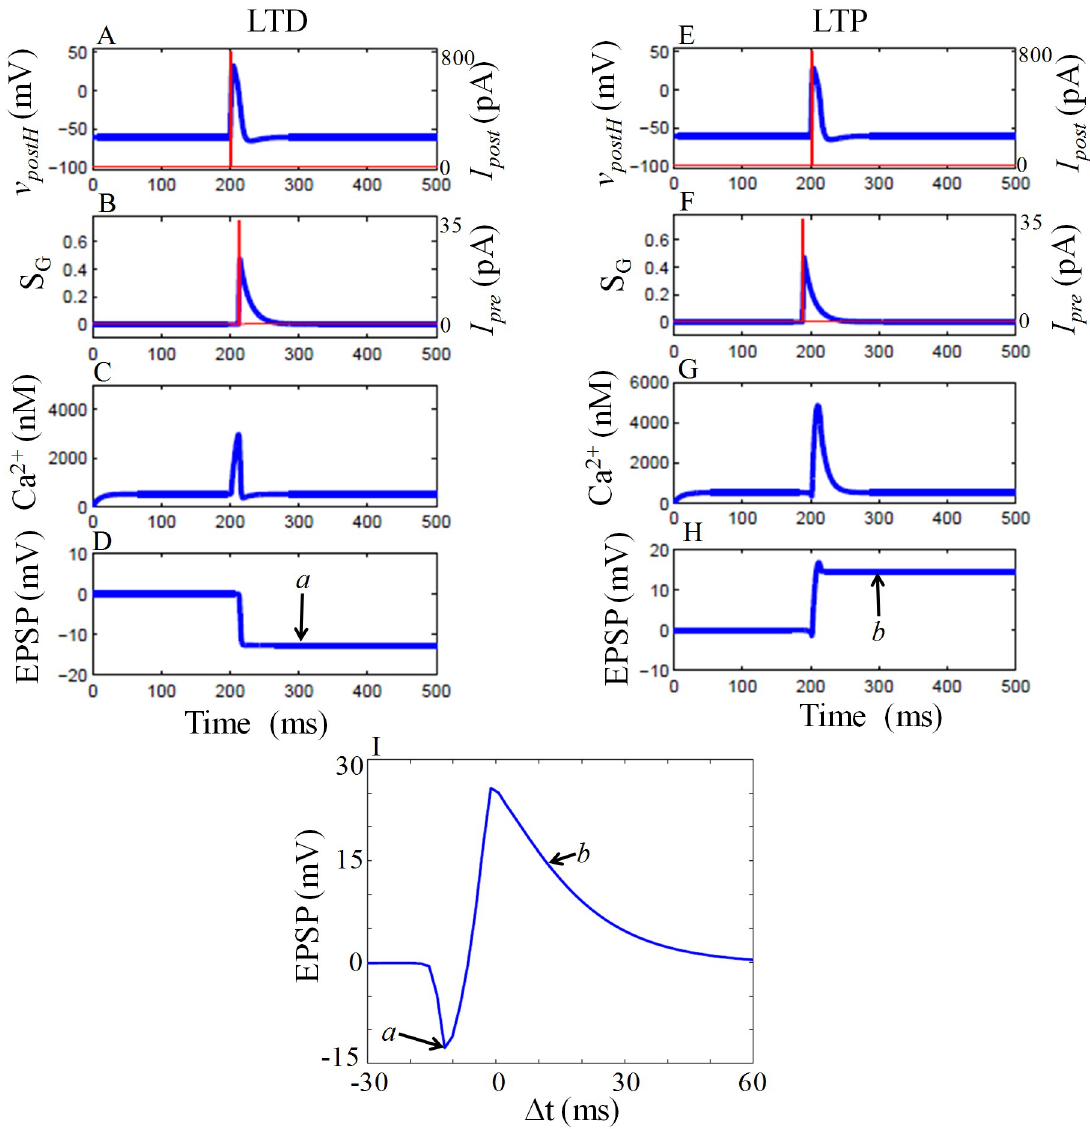
Fig 4. Time series of variables for STDP without GRN. In simulation, we apply I post at t = 200 ms (A, E, red line), which induce a spike at post-synaptic neuron (A, E, blue line). (B) When Δ t = − 12 ms , I fraction of glutamate binds to NMDAR (blue line). (C) Dynamics of the Ca 2+ . (D) Moderate increase of Ca 2+ level induce a negative change in the EPSP, which is the measure of LTD. (F) When Δ t = + 12 ms , I release and fraction of glutamate that binds on NMDAR (blue line). (G) Dynamics of Ca 2+ . In comparison to previous case in (C), increment of Ca 2+ level is higher that results in a positive change in the EPSP (H), a measure of LTP. (I) EPSP as a function of Δ t . LTP and LTD occur when Δ t is positive or negative respectively. If the temporal difference between I happens. EPSP value obtained at t = 300 ms ( a , b ) is used to construct STDP curve. The magnitude of the I pre and I post are 35 pA and 800 pA respectively, and the duration of the current is 2 ms . Here we take g